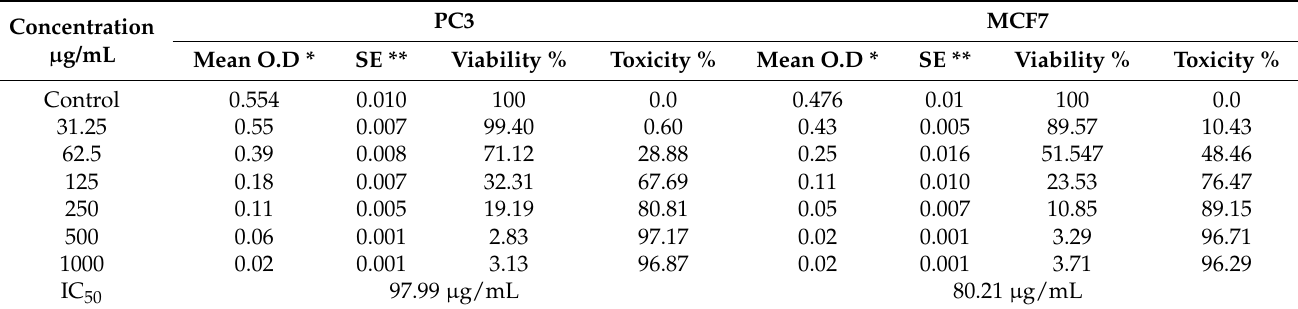
Table 6. Cytotoxicity of M. pulegium L extract against PC3 and MCF7 at different concentrations.